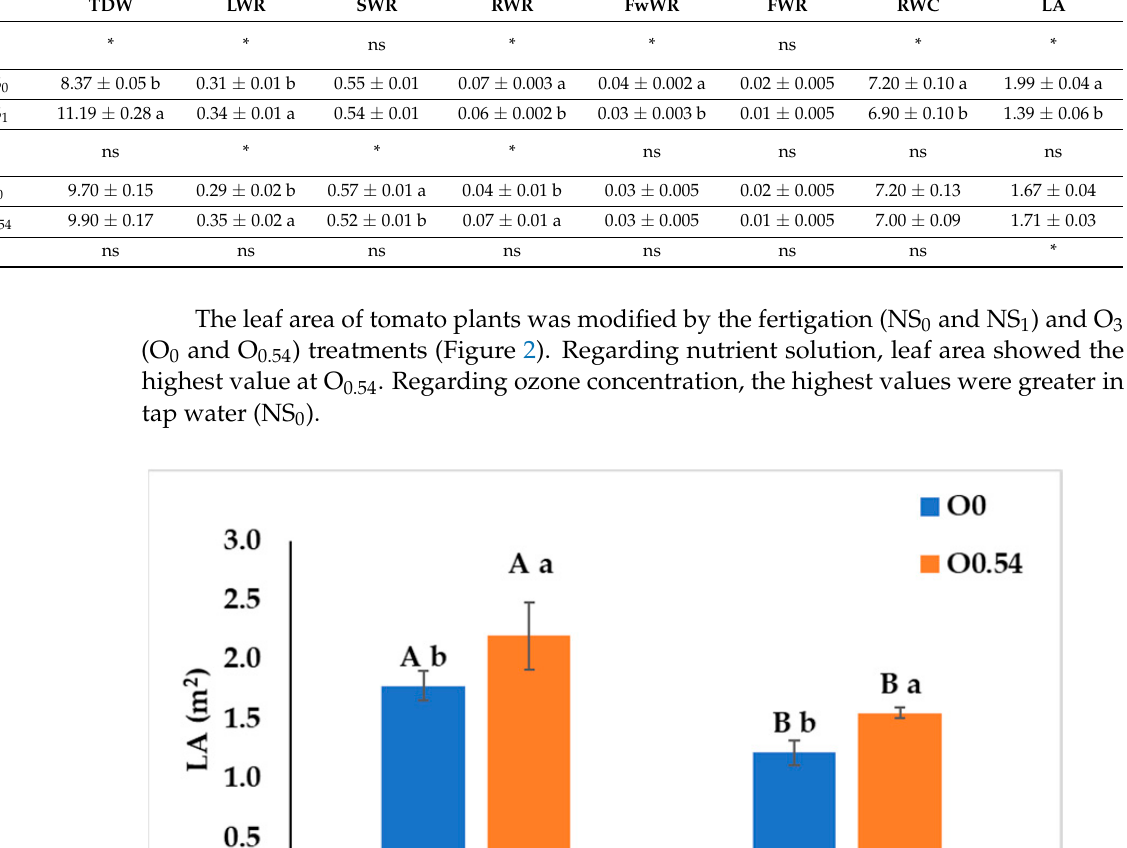
Table 5. Effects of fertigation and ozone on S. lycopersicum seedlings’ total dry weight (g) (TDW), relative leaf weight ratio (LWR), stem weight ratio (SWR), root weight ratio (RWR), flower weight ratio (FwWR), fruit weight ratio (FWR), relative water content (RWC) and leaf area (LA) (m 2 ). The data recorded are the means ± standard deviation of four samples per treatment at the end of the experimental period. In each column, different letters or an asterisk (*) denote statistically significant changes between treatments (LSD test; p < 0.05). ns indicates non-statistical differences between treatments.